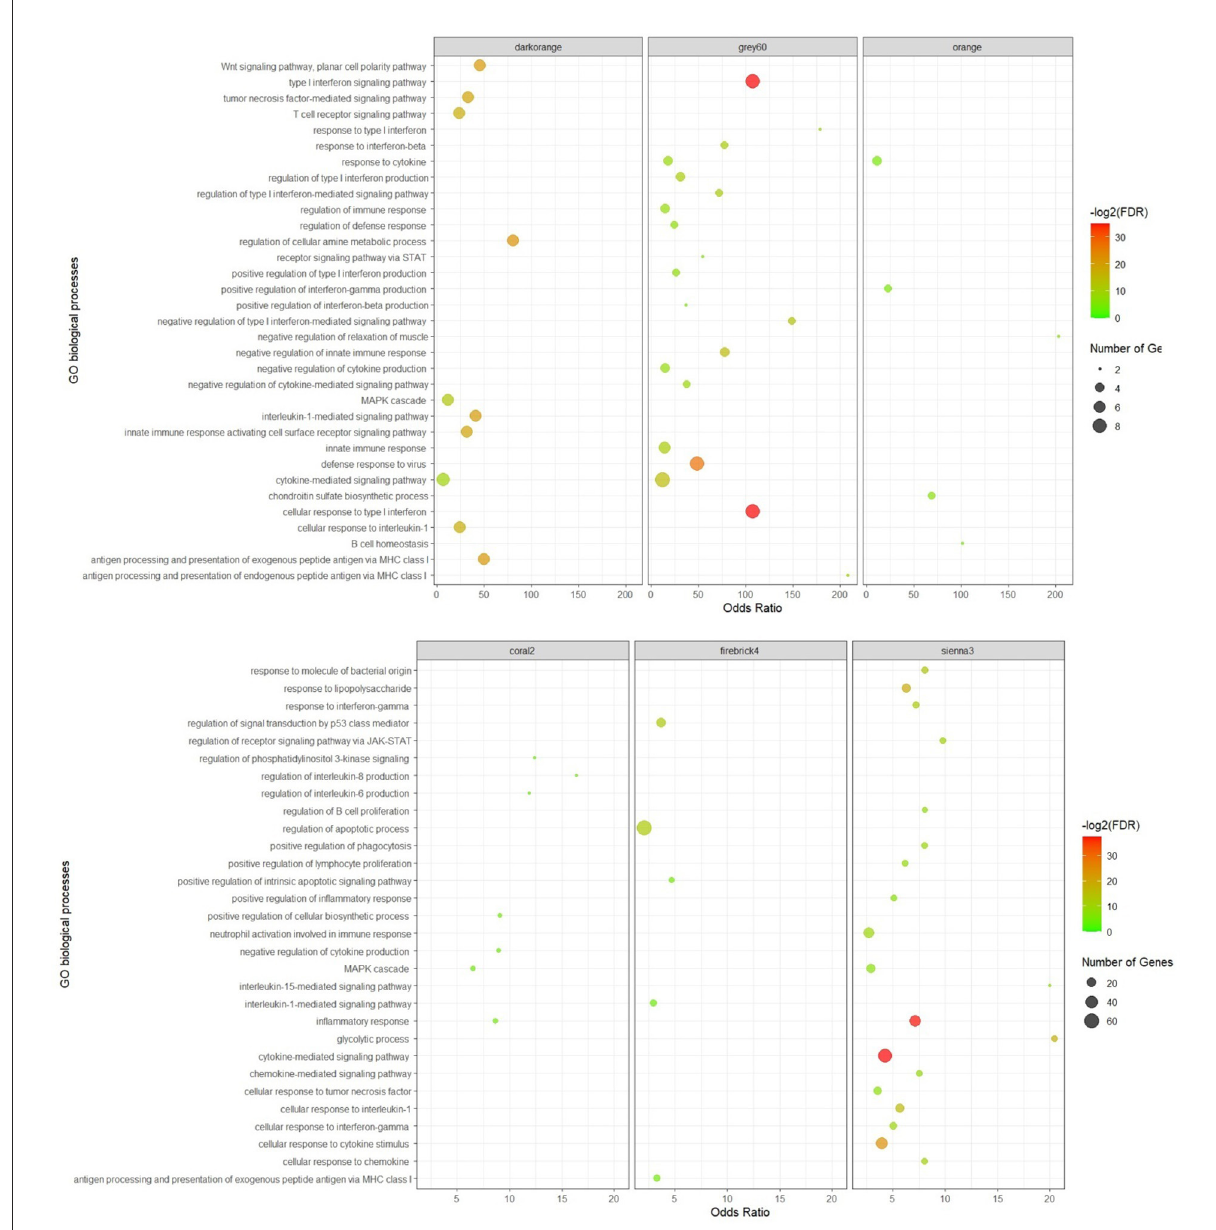
FIGURE3 Significant biological processes for the genes in the non-preserved consensus modules. Only top 20 terms were presented for grey60 and sienna3 modules, as they have a lot of significant